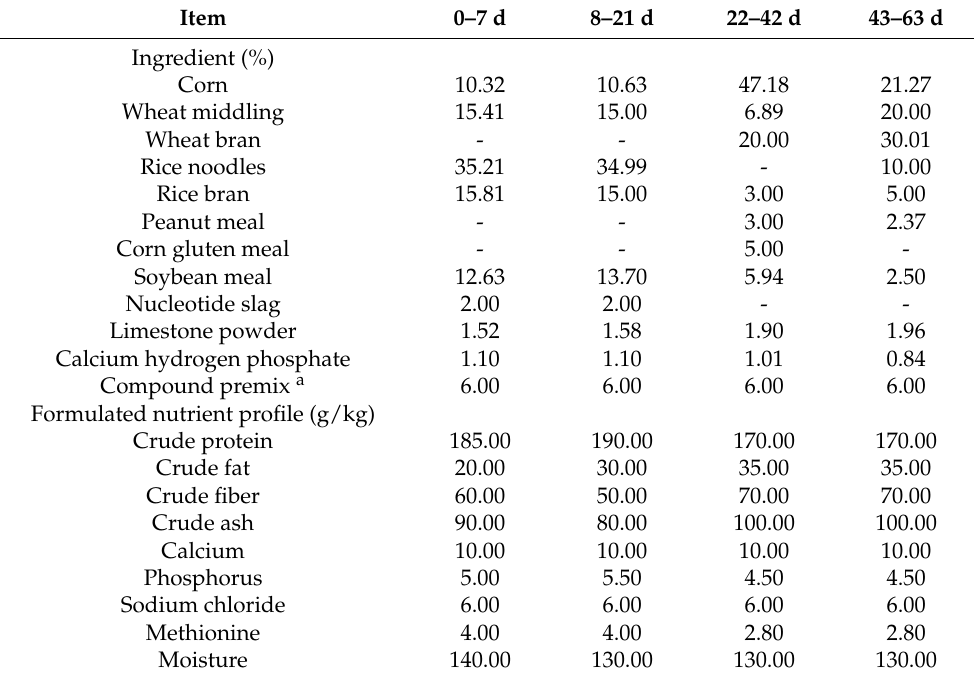
Table 1. Compositions and nutrients of the experimental diets (%, as